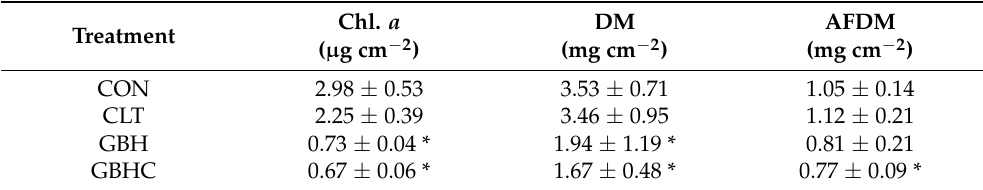
Table 1. Phytobenthos biomass included areal chlorophyll a (Chl. a ), dry mass (DM), and ash-free dry mass (AFDM), measured 36 h after removal following a short-term (12 h) herbicide pulse compared to control samples (CON) of unamended stream water. Herbicide treatments include chlorotoluron (CLT), glyphosate (GBH), and a mixture of the two herbicides (GBHC); values are means ± SE, n = 5, * = p <